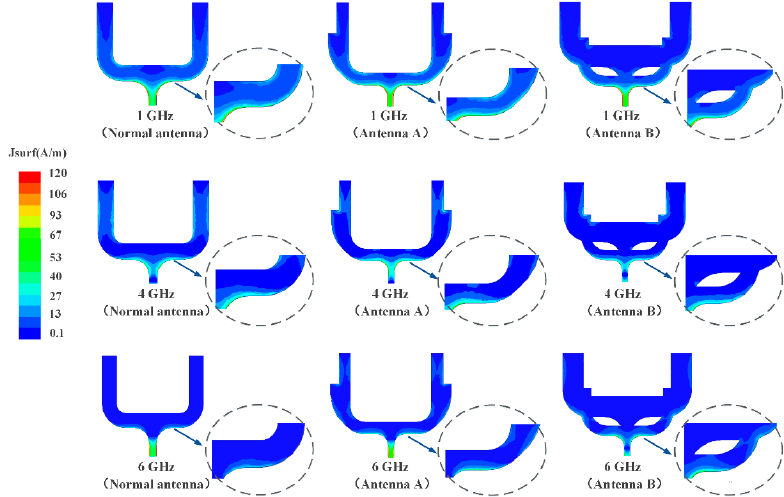
Figure 7. Simulated current distributions of the normal WS antenna and the proposed antennas at a frequency of 1 GHz, 4 GHz, and 6 GHz.